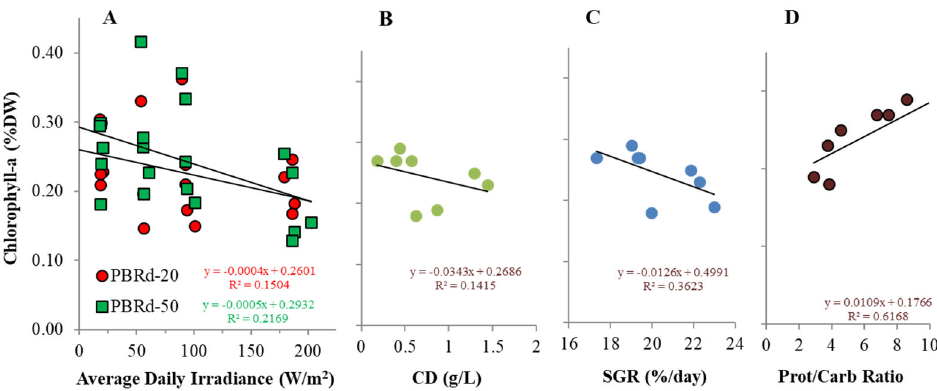
Figure 6. Chlorophyll-a content of an outdoor A. platensis culture in response to daily irradiance ( A ), and its relationships with culture density ( B ), specific growth rate ( C ), and protein:carbohydrate ratio ( D ).